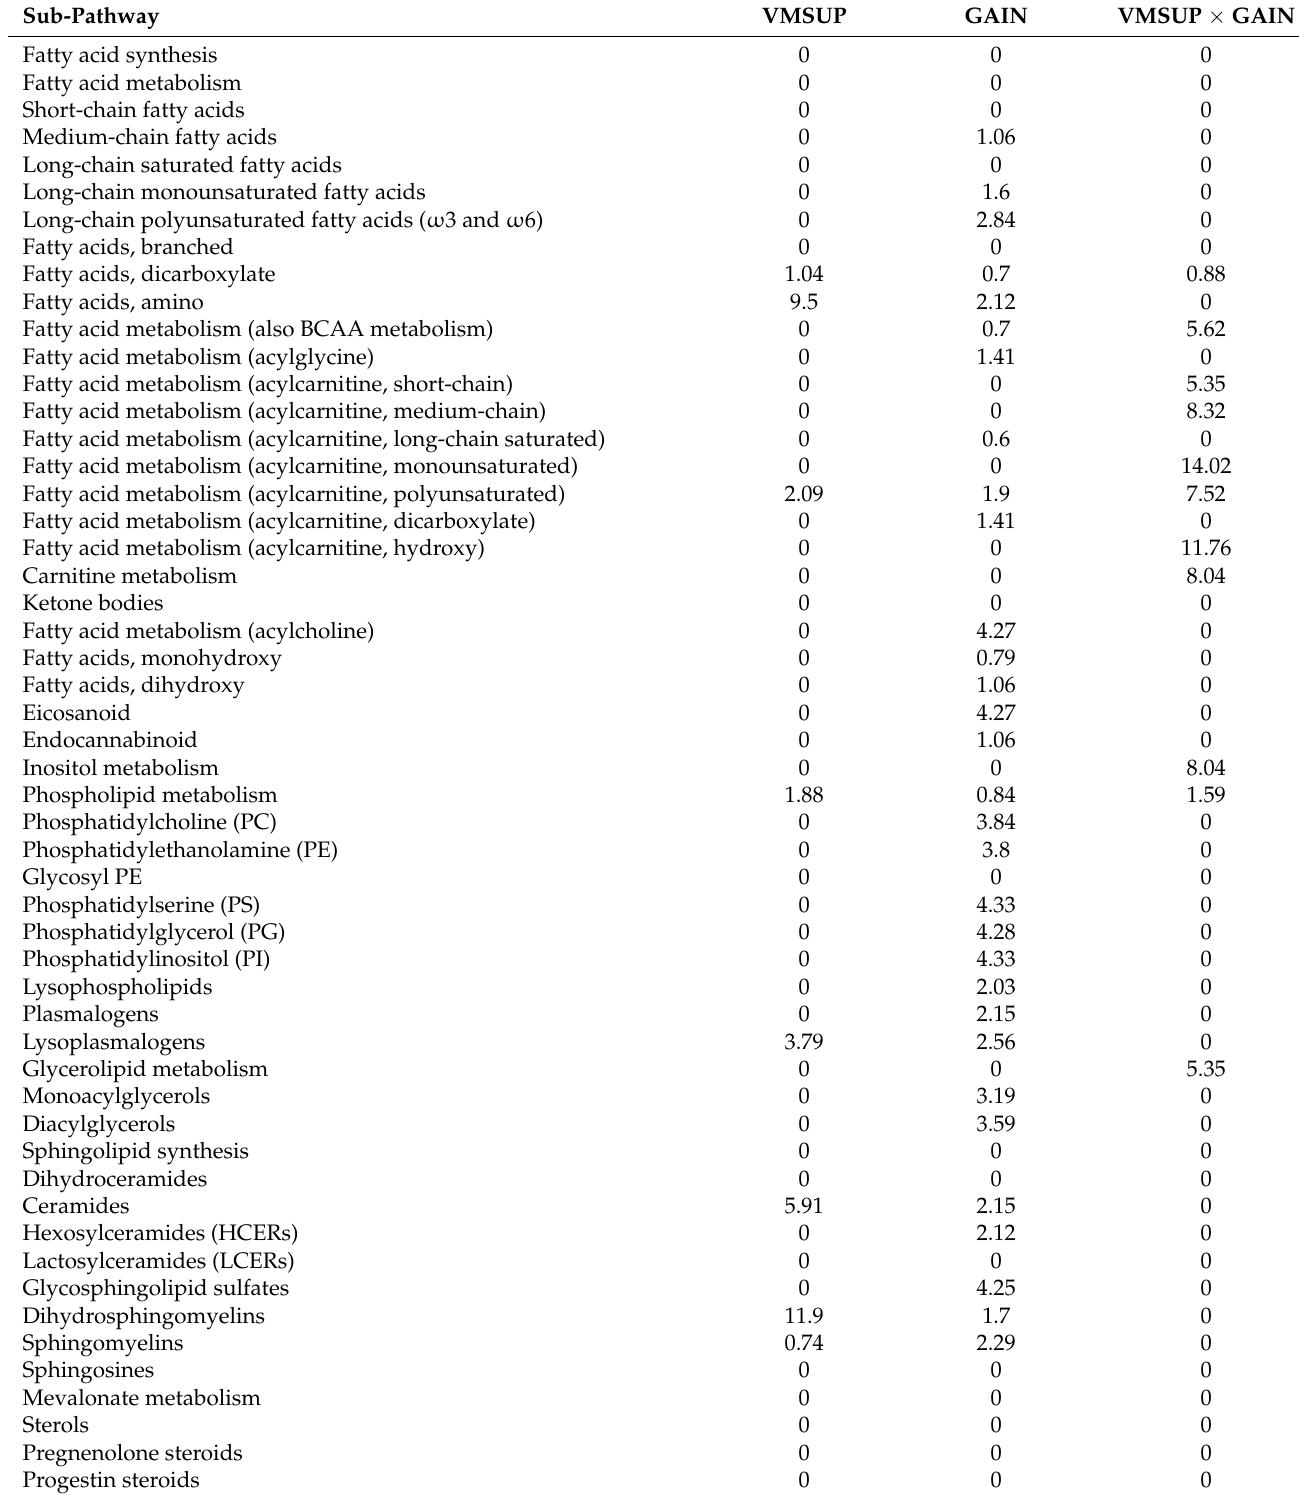
Table 1. Enrichment scores for each sub-pathway identified. Sub-pathways with enrichment scores > 1 have more biochemicals/metabolites with statistically significant fold changes compared to all other sub-pathways within the study 1